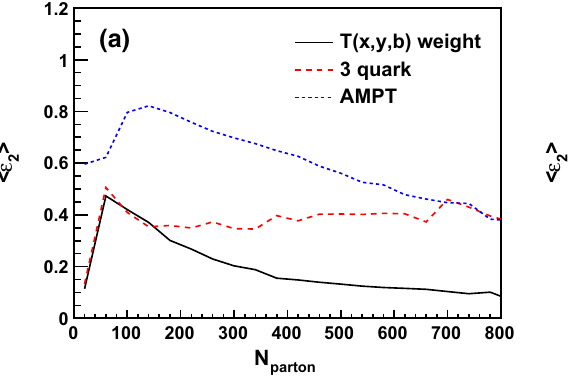
Fig. 4 Initial eccentricity versus the number of partons after string melting ( a ) and impact parameter ( b ) for proton geometry with overlap function method (black solid line) and quark constituent picture (red